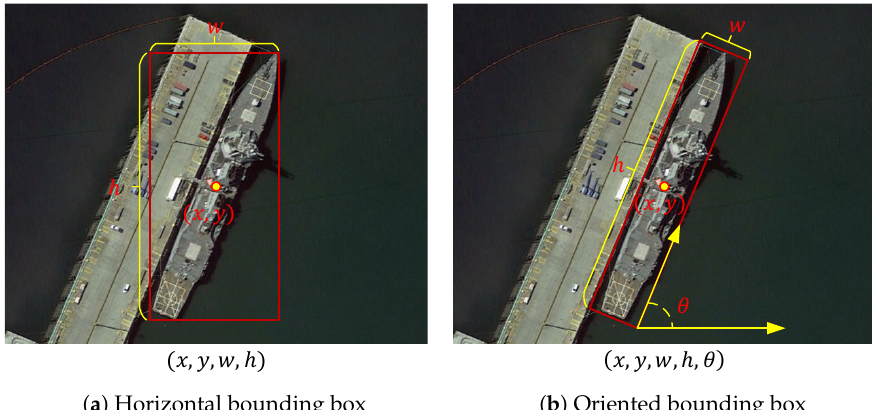
Figure 1. Horizontal bounding box ( a ) versus oriented bounding box ( b ), taking ship detection as an example. Point ( x , y ) denotes the coordinates of the center point of the target, while ( w , h ) denotes the width and height of the bounding boxes, respectively. The oriented bounding box, in particular, utilizes an extra parameter θ to represent the angle information making it better for locating aerial